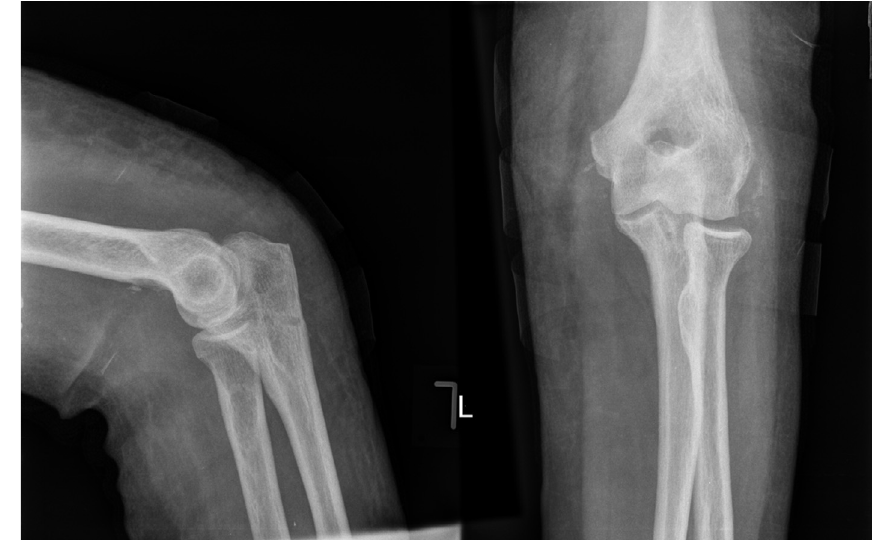
Figure 5. Elbow AP and lateral radiographs two weeks post initial reconstruction.